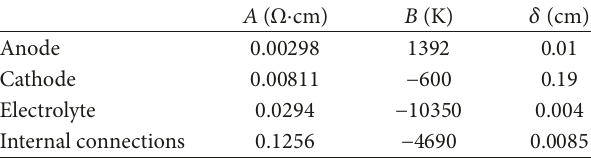
Table 1: IRSOFC resistivity constants